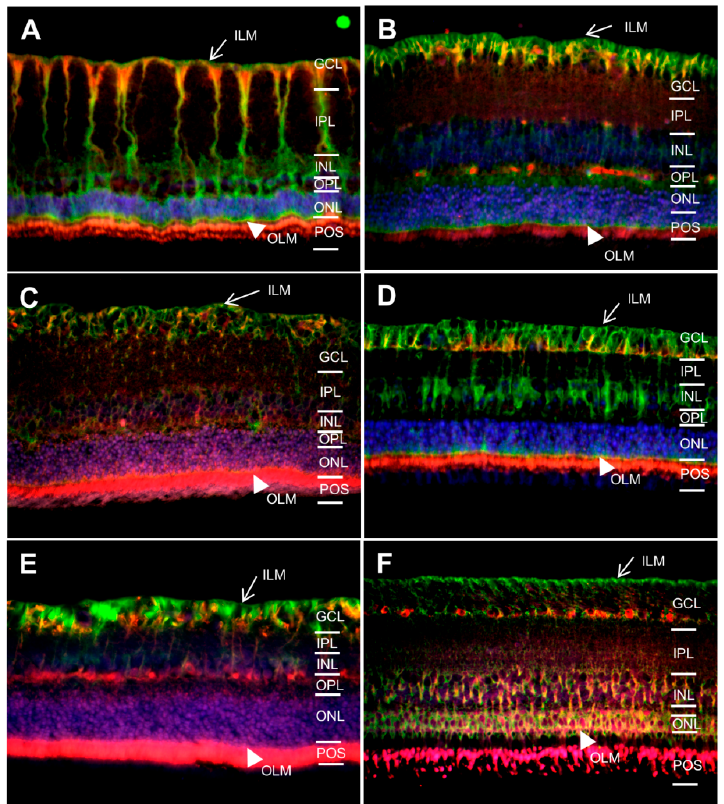
Figure 5. Overlay (yellow) of AQP11 (red) with Muller glial marker glutamine synthase (GS, green; magnification ×40). ILM, inner limiting membrane (arrow); GCL, ganglion cell layer; IPL, inner plexiform layer; INL, inner nuclear layer; OPL, outer plexiform layer; ONL, outer nuclear layer; OLM, outer limiting membrane (arrowhead); POS, photoreceptor outer segments. ( A ) horse; ( B ) mouse; ( C ) rat; ( D ) guinea pig; ( E ) cat; ( F ) chicken. Cell nuclei: blue (DAPI).